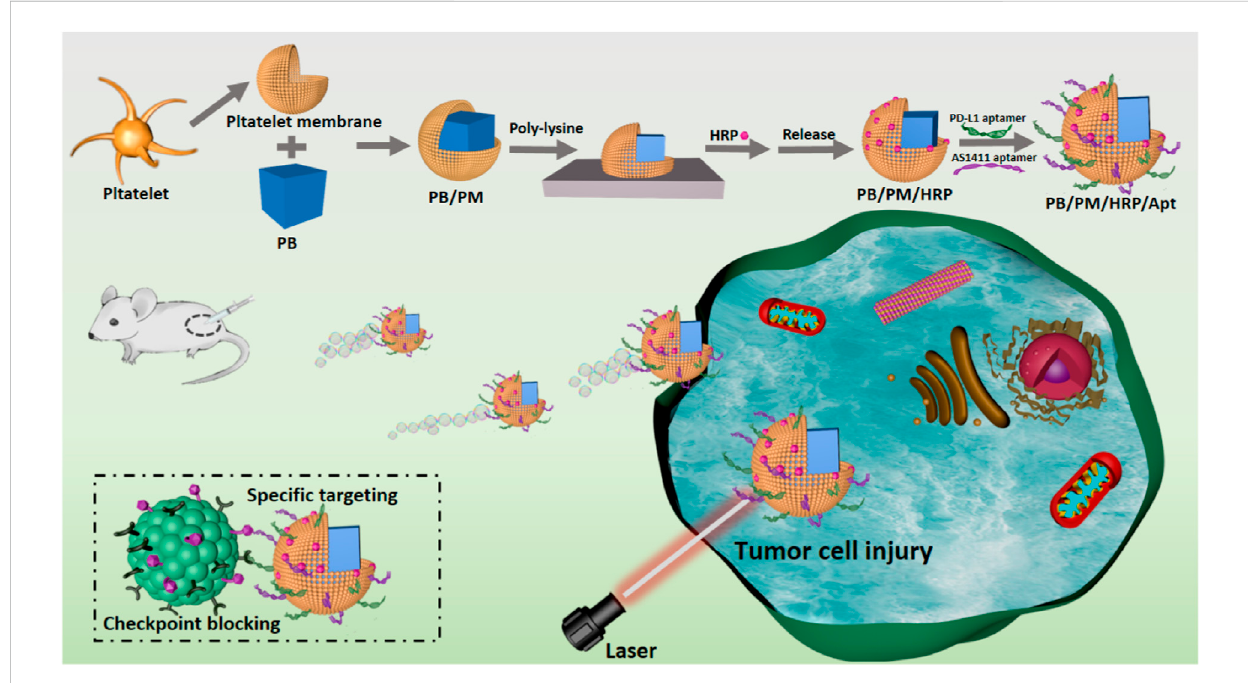
Schematic diagram of the synthesis and preparation process of PB/PM/HRP/Apt biomimetic nanocomposite and the mechanism of collaborative